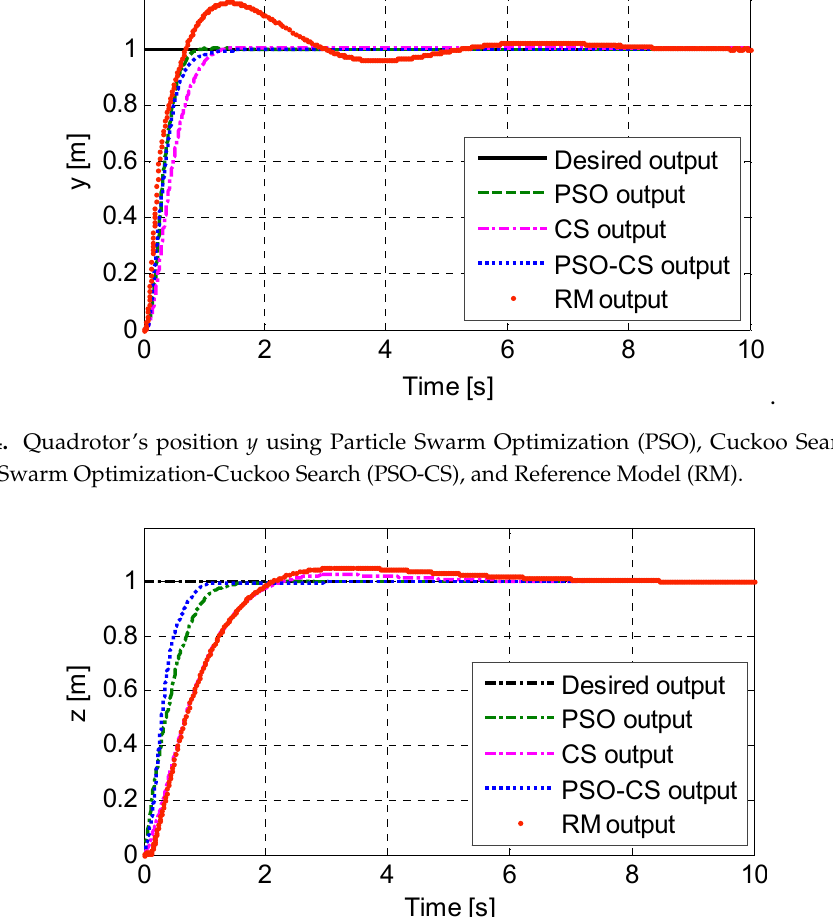
Particle Swarm Optimization-Cuckoo Search (PSO-CS), and Reference Model (RM).